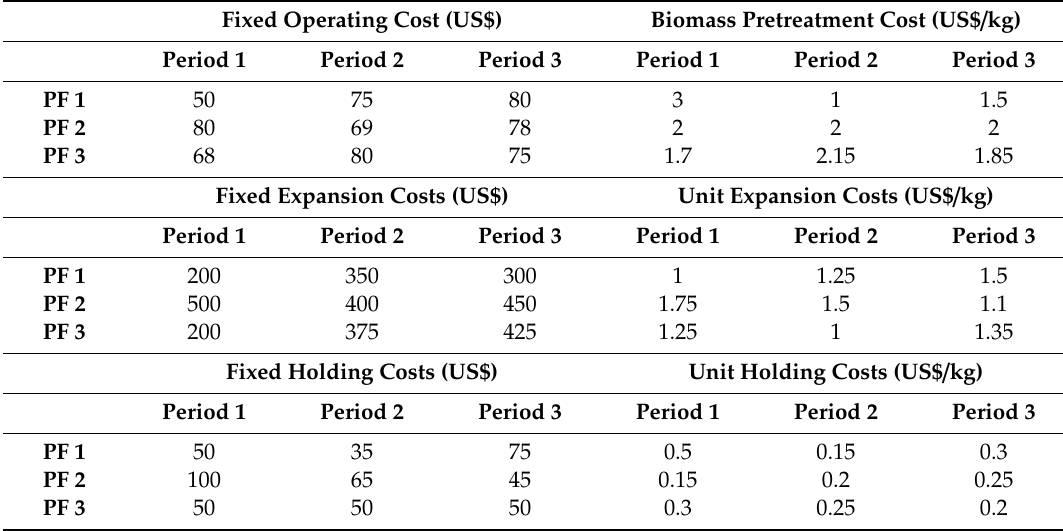
Table A6. Pretreatment Facility Costs.